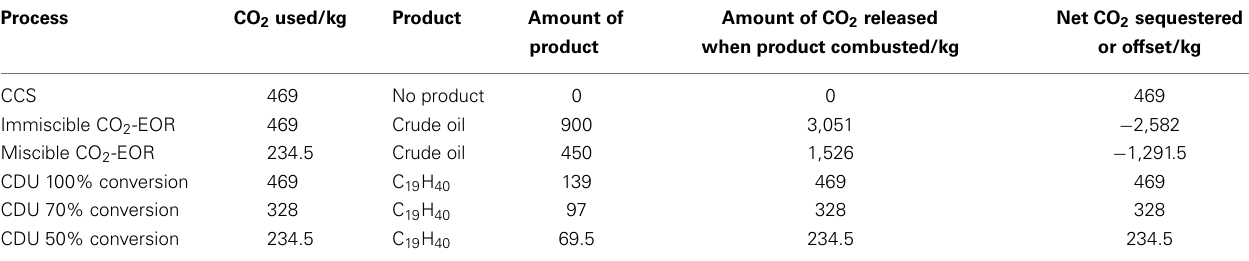
Table 4 | Comparisons of net CO 2 emissions using the CCS, EHR, and CDU strategies discussed .